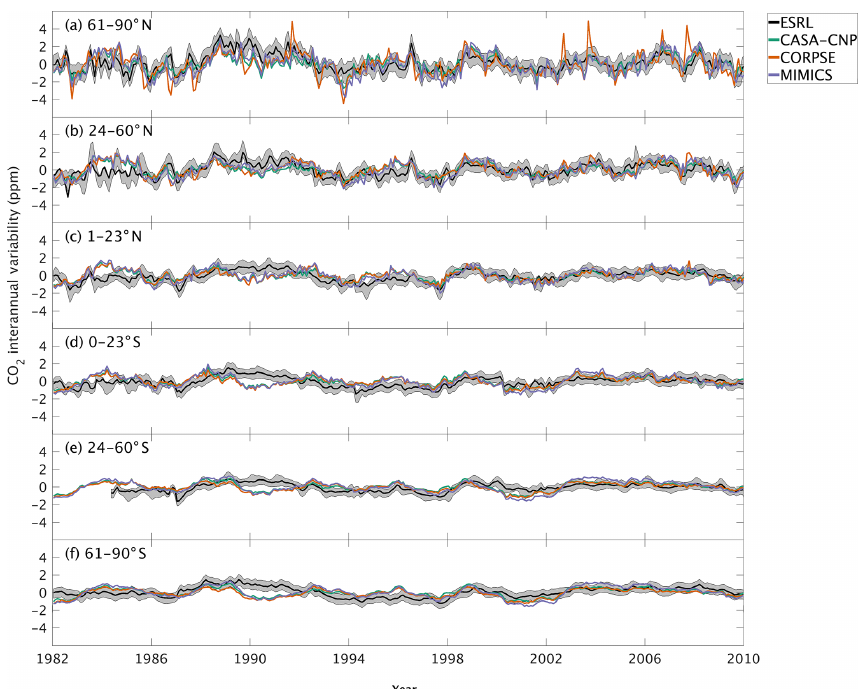
Figure 5. Interannual variability of CO 2 from global net ecosystem productivity (CO NEP boundary layer observations from the NOAA ESRL network (black). Gray shading outlines 1 standard deviation of observed CO 2 interannual variability. High-latitude, midlatitude, and tropical land belts are shown for the Northern Hemisphere (a–c) and Southern Hemisphere (d–f)